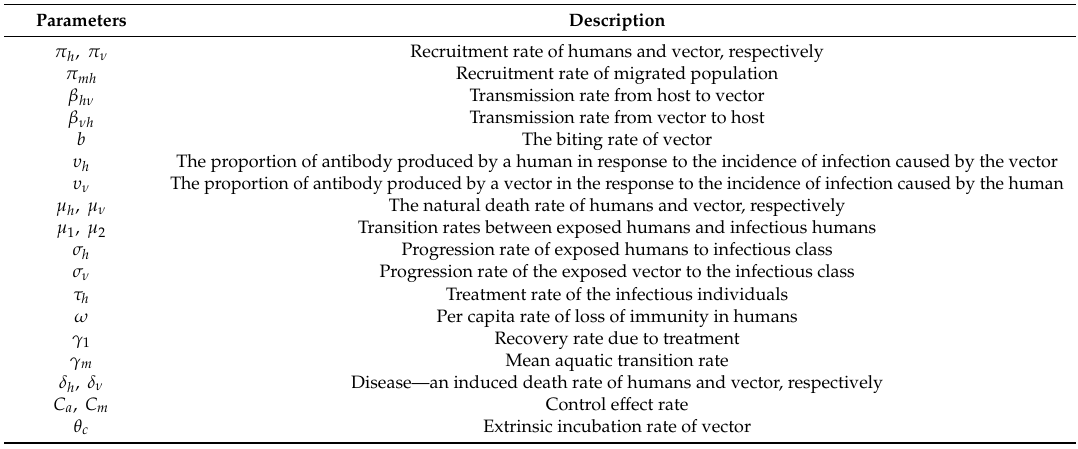
Table 1. Description of the parameters of the Dengue model, Equation